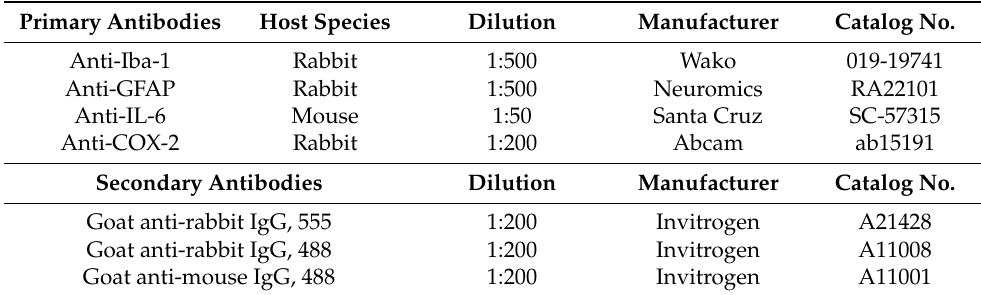
Table 3. Primary and secondary antibodies used in IHC